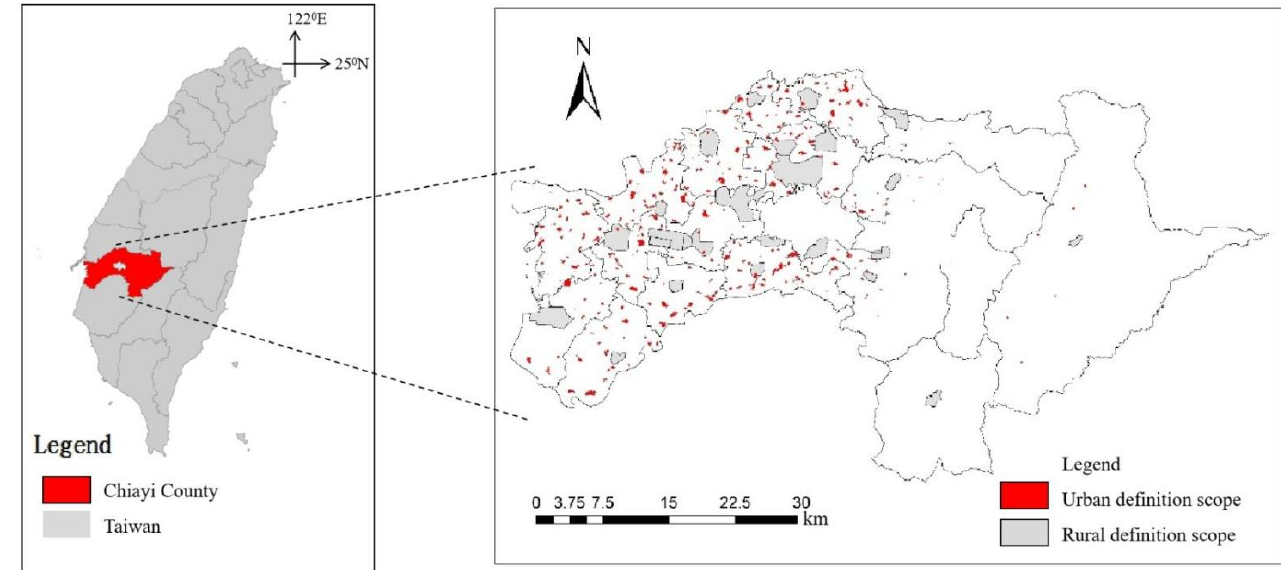
Figure 2. Research scope and spatial distribution of urban and rural areas.